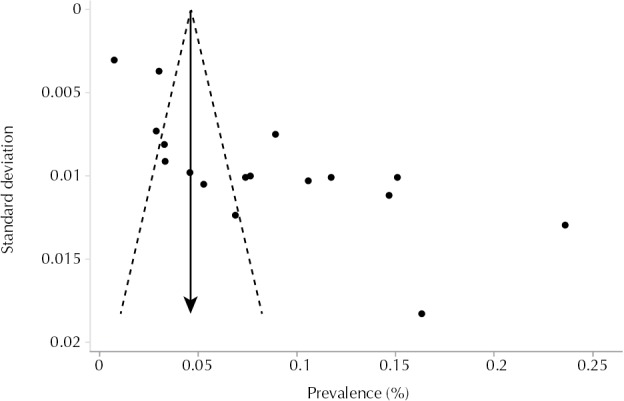
Funnel chart: prevalence of hypertension in each study by the standard deviation of the studies.